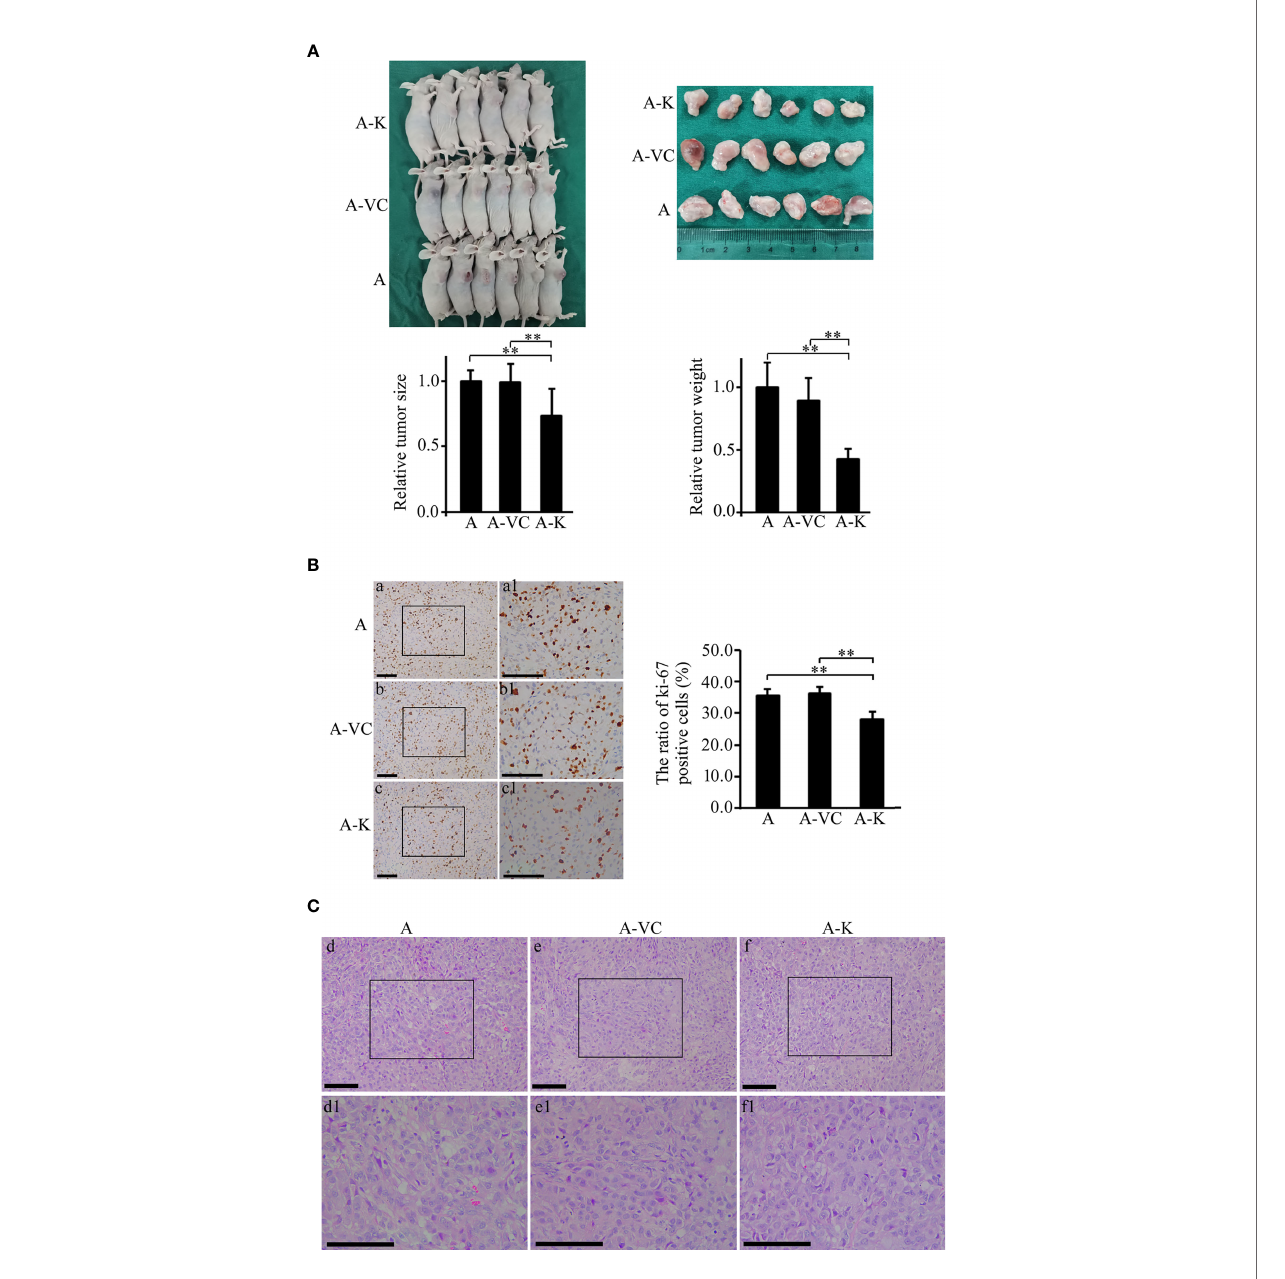
FIGURE 5 | Overexpression of KDF1 signi fi cantly decreased the growth of transgrafted tumors and the ratio of ki-67 positive cells in the tumor. Four-week old male nude mice were randomly divided into non-transduced cell group, control virus transduced cell group and KDF1 overexpression cell group. Six mice were used in each group. For each mouse, 2×10 6 cells (untransduced ACHN cells for the untransduced cell group, control virus transduced ACHN cells for the control virus transduced cell group, and KDF1 overexpression ACHN cells for the KDF1 overexpression cell group) were transplanted subcutaneously on the side of the body. Six weeks later, the mice were euthanized and the tumors were removed, measured and weighed. Paraf fi n sections of the transgrafted tumors were used in Hematoxylin-Eosin (HE) staining and immunohistochemical staining for ki-67. Figure part (A) Results of the tumor transplant trial showing that overexpression of KDF1 decreased the growth of transgrafted tumors. Figure part (B) Results of immunohistochemical staining for ki-67 showing that overexpression of KDF1 decreased the ratio of ki-67 positive cells in the transgrafted tumors. Figure part (C) Results of HE staining showing no structural difference among the tumor tissues. A, the untransduced cell group; A-VC, the control virus transduced cell group; A-K, the KDF1 overexpression cell group. a1-f1 is a partial magni fi cation of a-f, respectively. **P <